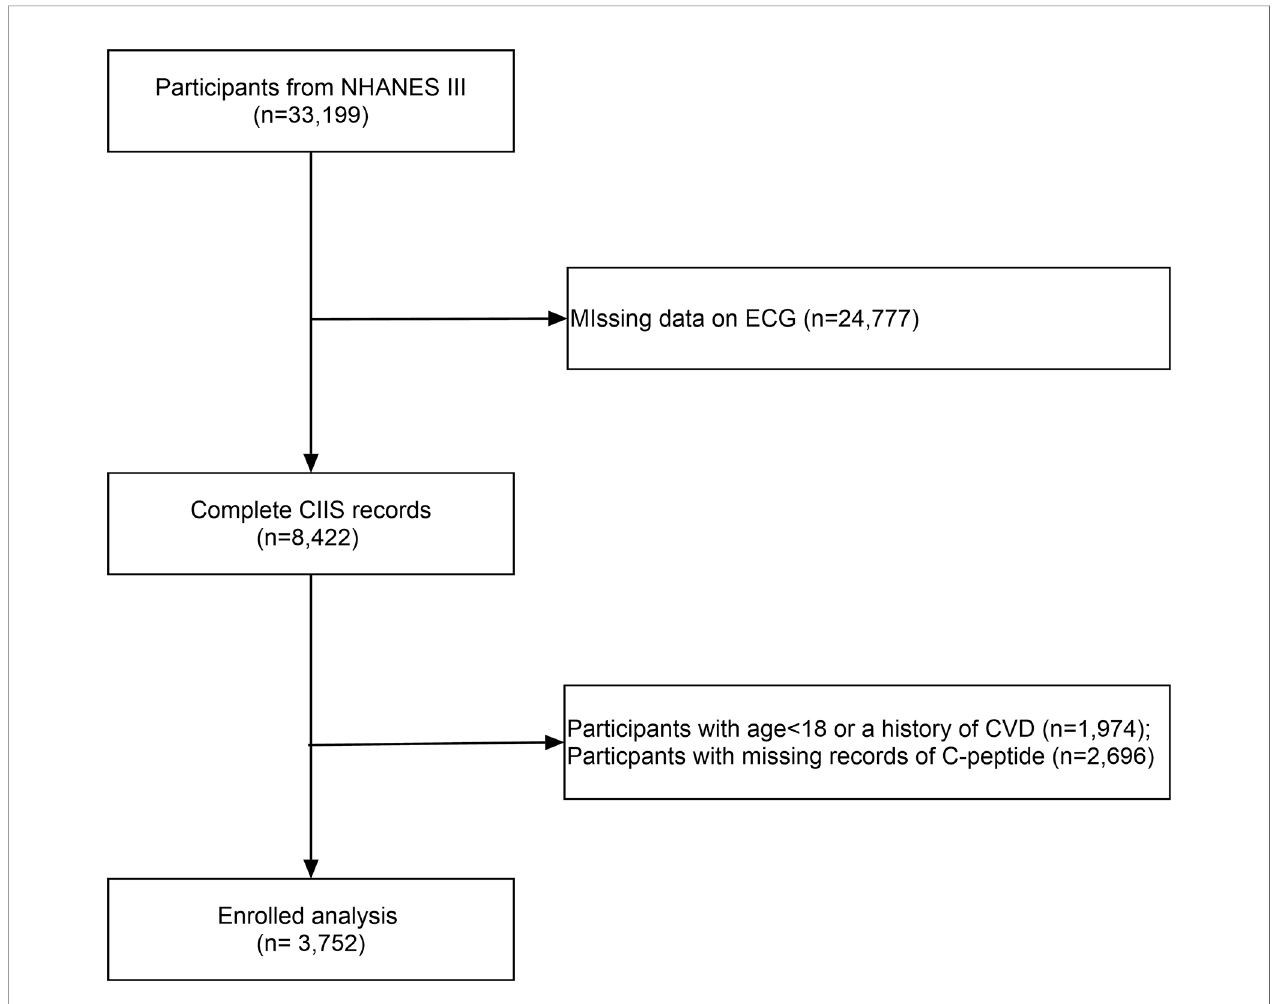
FIGURE 1 | The fl ow chart of the selection